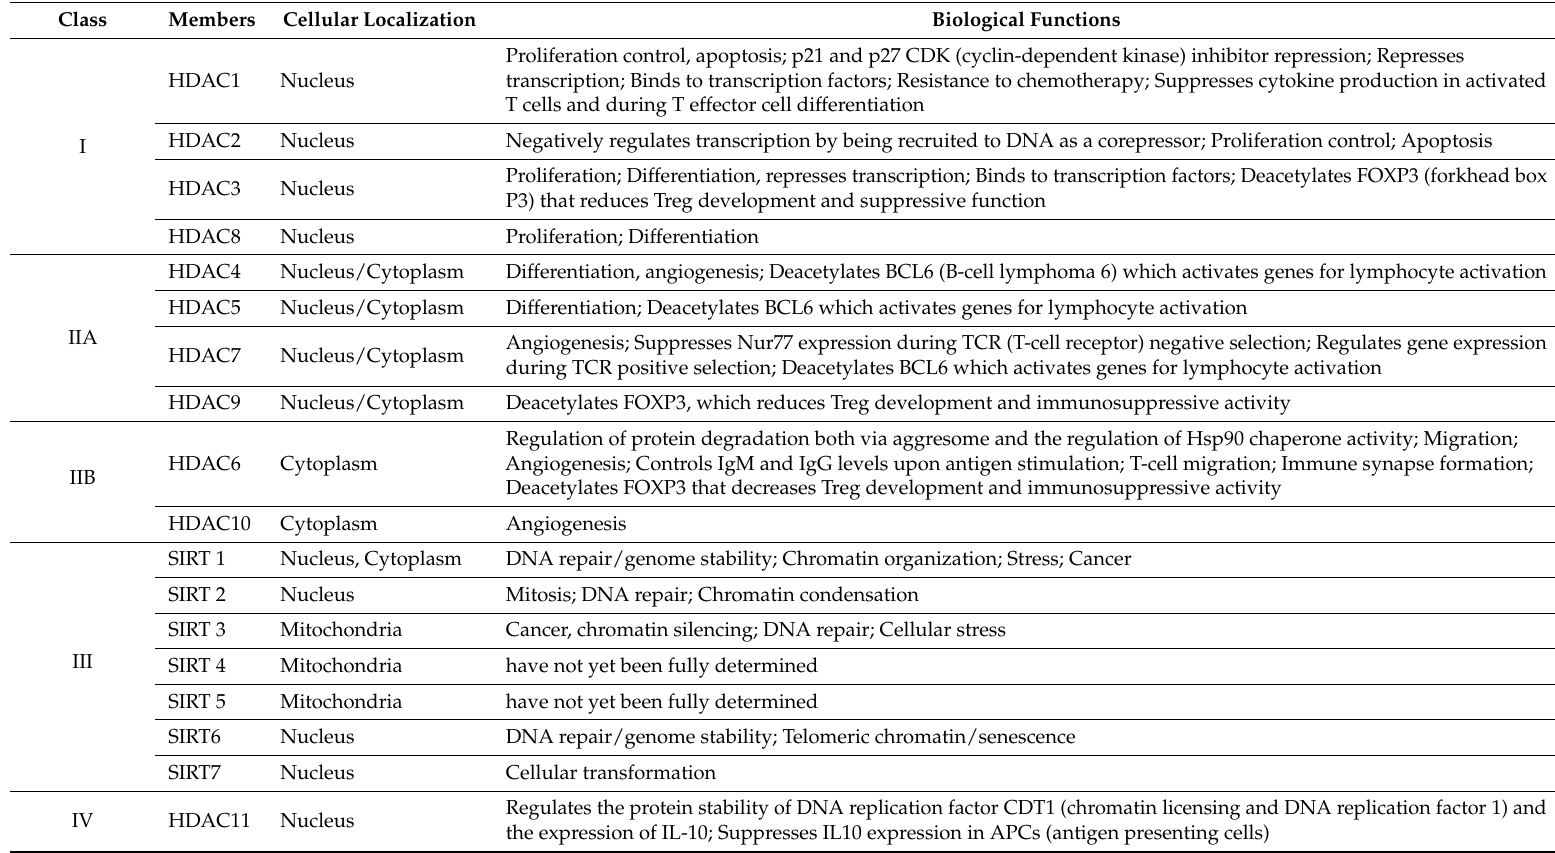
Table 1. Histone deacetylases (HDACs) classification, their localization and biological